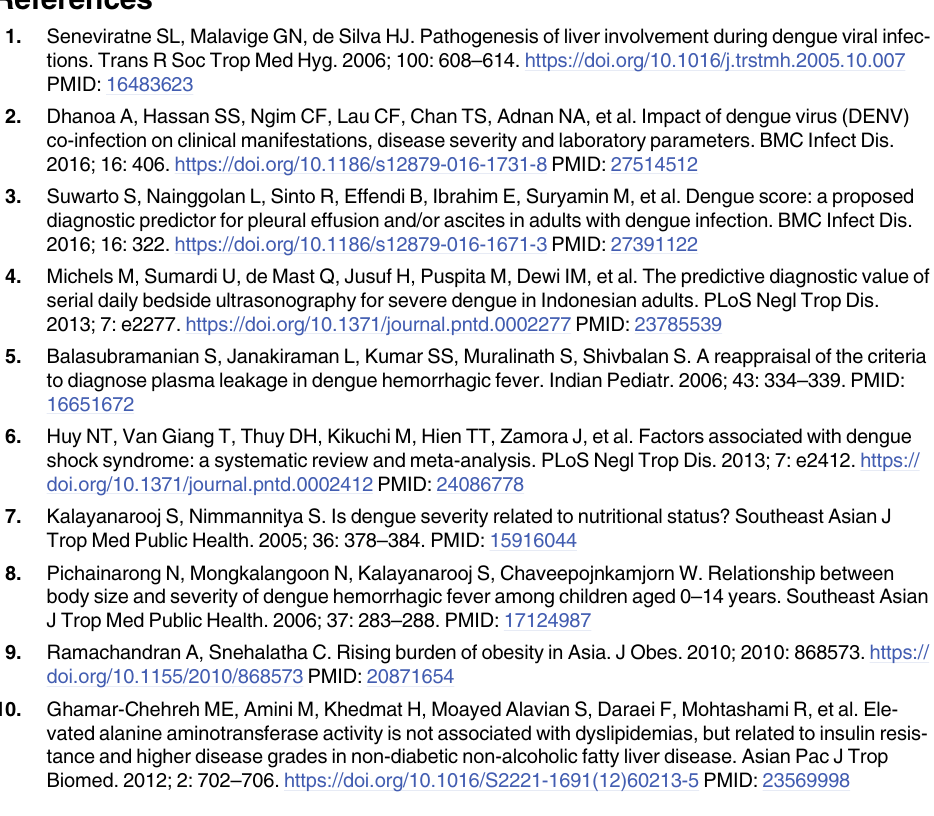
S3 Table. Differences between the absence and presence of NAFLD in the leakage groups. Abbreviations: NAFLD, non-alcoholic fatty liver disease; AST, aspartate aminotransferase; ALT, alanine aminotransferase; IQR, interquartile range. Statistical analysis was assessed by Mann-Whitney